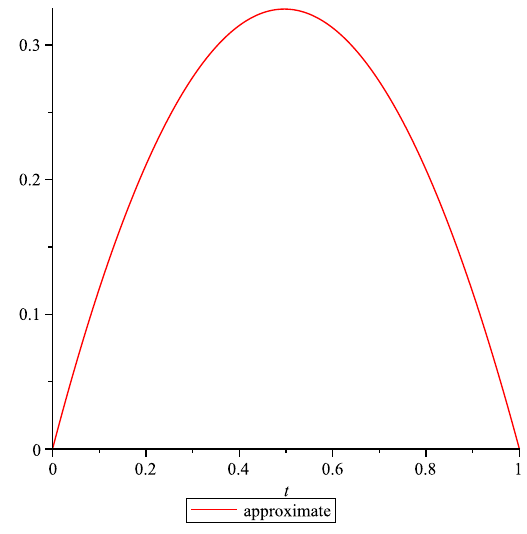
Figure 2: The graph of approximated u ( x ) for Example 2.